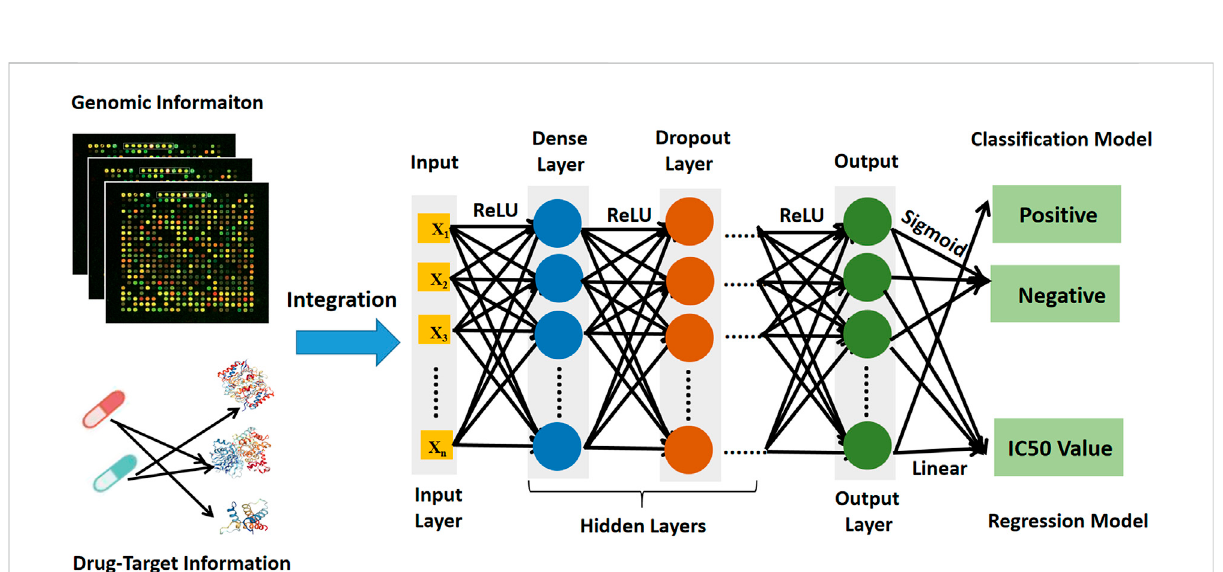
FIGURE 2 The architecture diagram of deep learning prediction model showing data sources and work fl